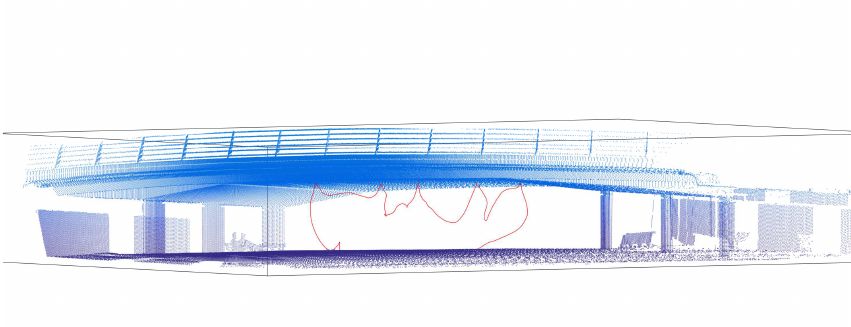
Figure 17. Prism trajectory measured with the laser tracker—Cartuja bridge experiments.